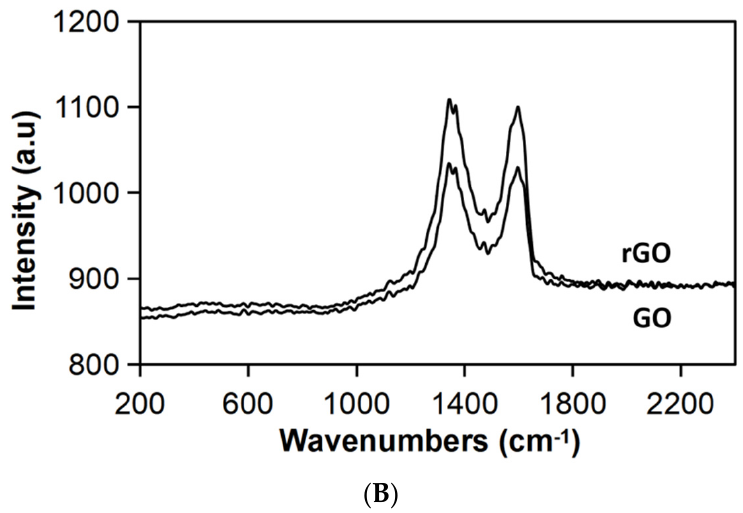
Figure 2. ( A ) PXRD patterns of ZIF-8 and mp20 encapsulated into ZIF-8 (mp20@ZIF-8) as compared to simulated pattern; ( B ) Raman spectra of GO and rGO on SPCE surface.